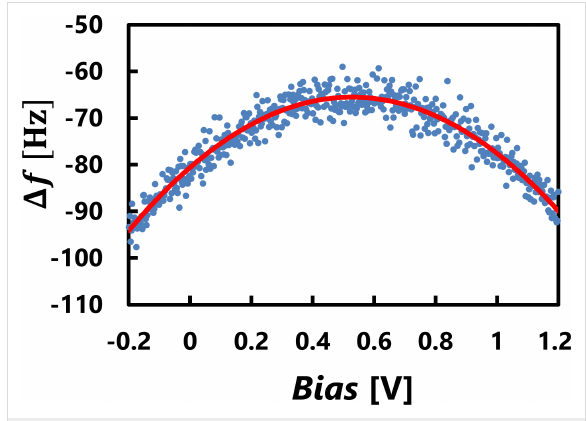
Figure 4: KPFS measurement on a TiO 2 (110) surface. KPFS data (blue dots) was fitted by Δ f ( V ) = a 1 V 2 + b 1 (red solid line), where 2 a 1 provides the value of